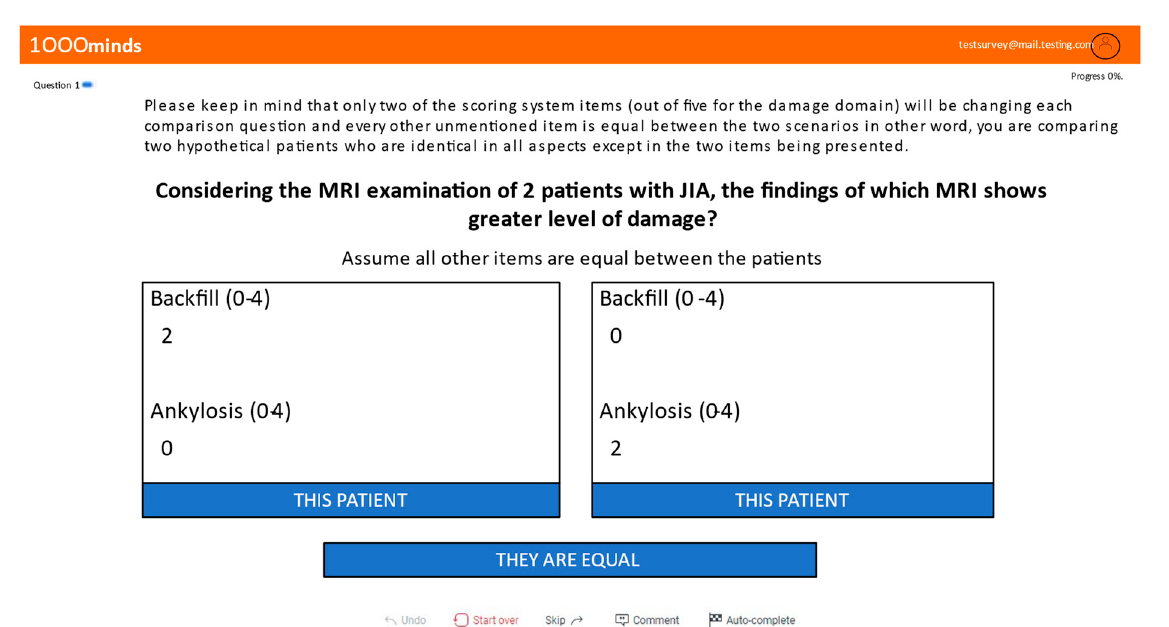
Figure A4. JAMRIS-SIJ grade-only vigne tt e used for ranking exercise to test conjoint analysis survey (CAS)-derived weights. Fourteen grade-only vigne tt es were constructed corresponding to various combinations of pathologies in the JAMRIS-SIJ. Experts individually ranked the cases from the greatest to least level of in fl ammation and damage, respectively. References 1.